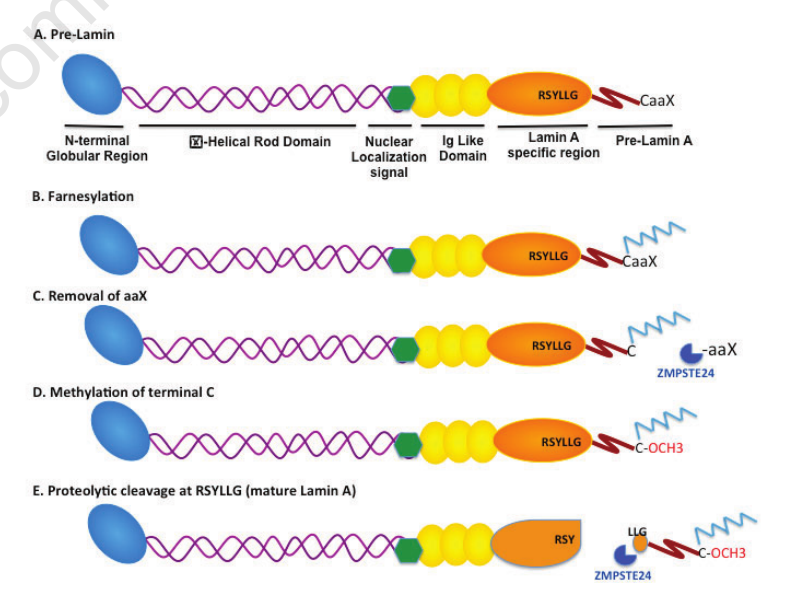
Figure 2. Steps involved in maturation of prelamin to Lamin A: Lamin is expressed as pre- lamin, which is comprised of 664 amino acids (Panel A). Prelamin mature into a 646 amino acid lamin A through a series of modification that include farnesylation at the C- terminus (Panel B), removal of the last three amino acids (AAX) (Panel C) followed by methylation at the last cysteine residue (Panel D) and finally cleavage of the last 15 amino acids at the RSY^LLG site by ZMPSTE24 (Panel E).